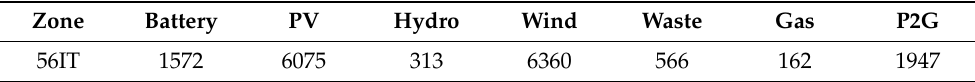
Table 4. Installed capacity (MW) provided by Task 1.1 for 2050 for Sicily [25]. Zone